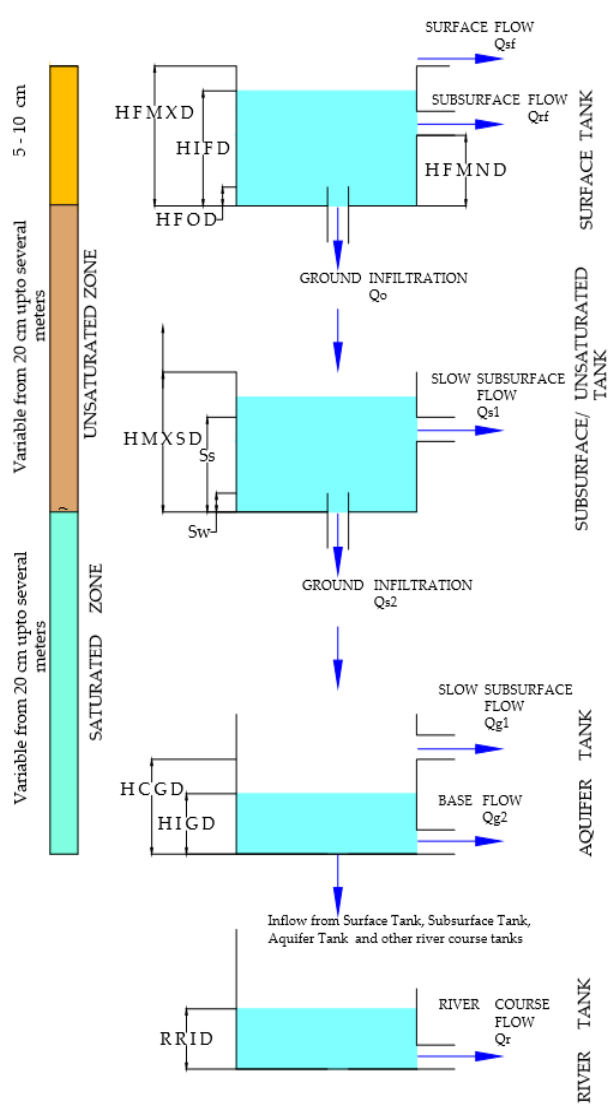
Fig. 1. Schematic configuration of IFAS model showing the classification of surface/subsurface